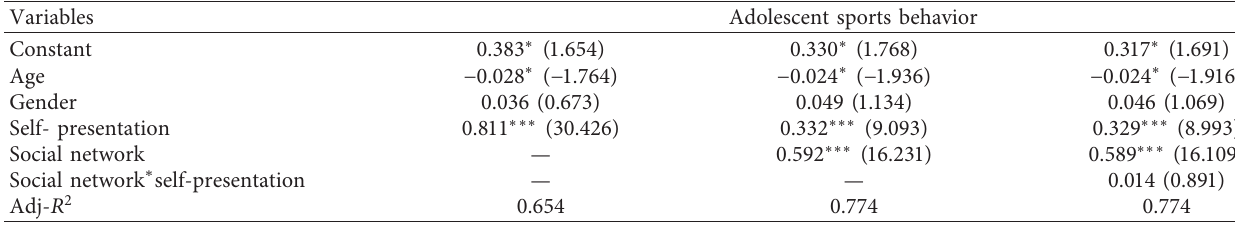
Table 4: Estimated results of moderating effect of self-presentation.